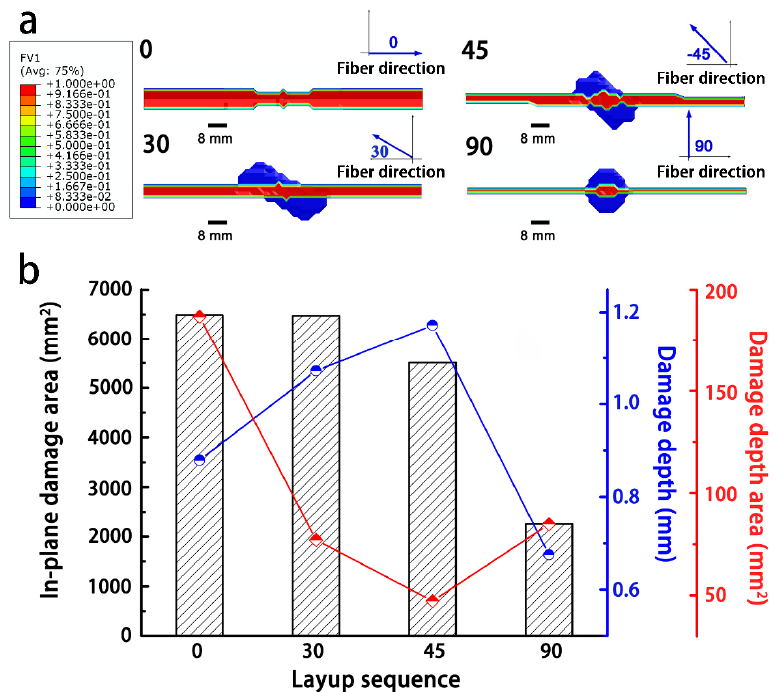
Figure 10. Influence of the layer sequence on the degree of damage from lightning to the composites: ( a ) damaged morphology; and ( b ) degree of damage to the composites.